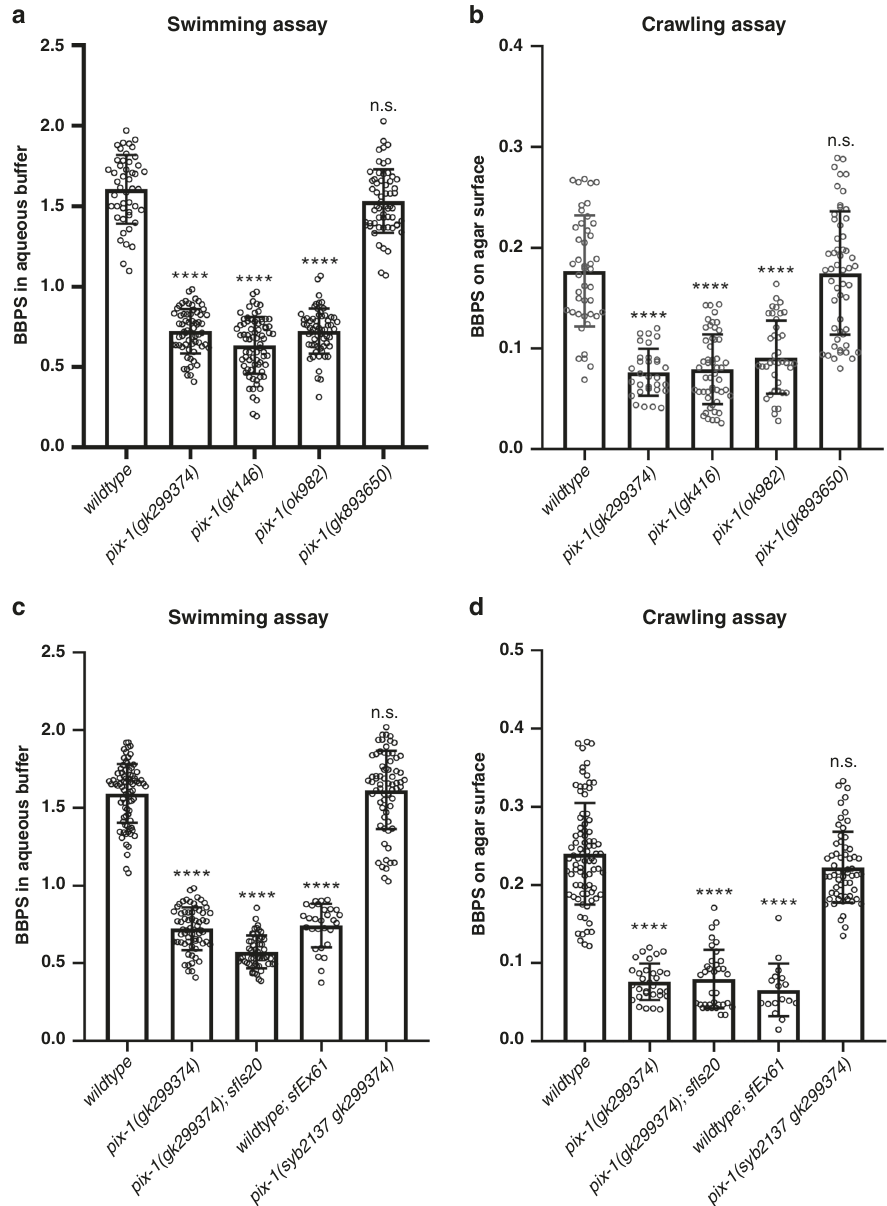
Fig. 4 Both loss of function and overexpression of pix-1 results in reduced locomotion. a Swimming and b crawling assays show that loss of function mutations in pix-1 result in reduced locomotion compared to wild type. c Swimming and d crawling assays show that both the integrated rescued strain, pix- 1(gk299374); sfIs20 , and wild type expressing the rescuing transgene from an extrachromosomal array, sfEx61 , have reduced locomotion. In contrast, CRISPR/Cas9 repair of the nonsense mutation in pix-1(gk299374) , called pix-1(syb2137 gk299374) , results in normalization of locomotion. In the graphs, each open circle represents the result from an independently selected animal. The exact n values vary, and these data can be found in the Source Data Files. Student ’ s two-sided t test was used to test for signi fi cance. Error bars: standard deviations; **** p ≤ 0.0001; n.s.: no signi fi cant